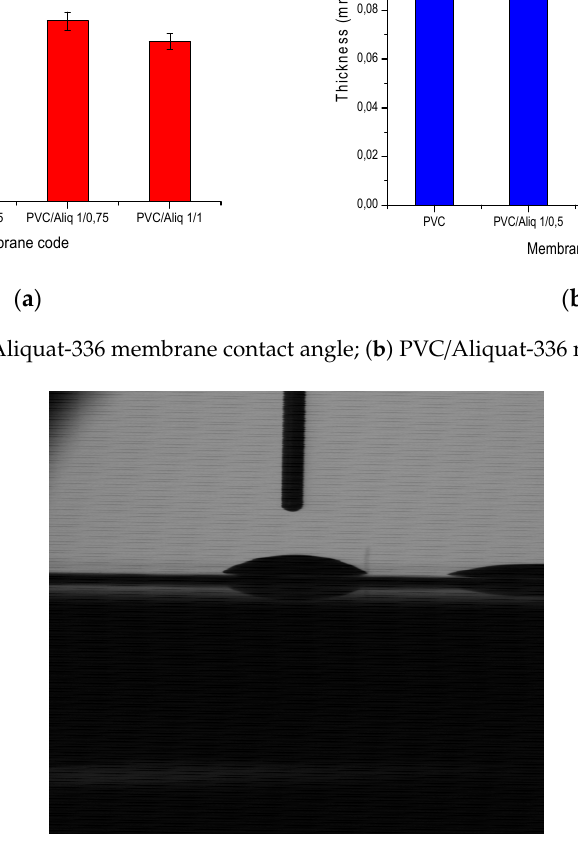
Figure 5. Photo of the water contact angle WCA measurement for the membrane at 1/0.75 PVC/Aliquat-336 ratio.